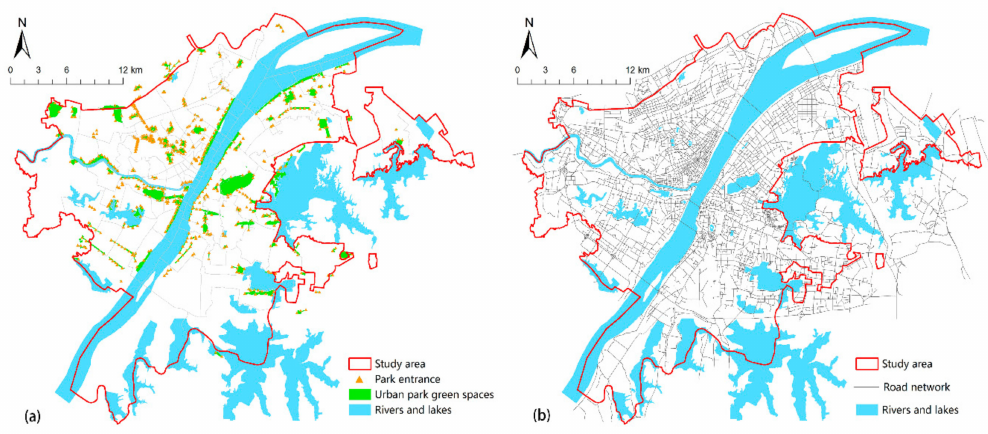
Figure 3. Urban park green space ( a ) and road network ( b ) in the central area of Wuhan